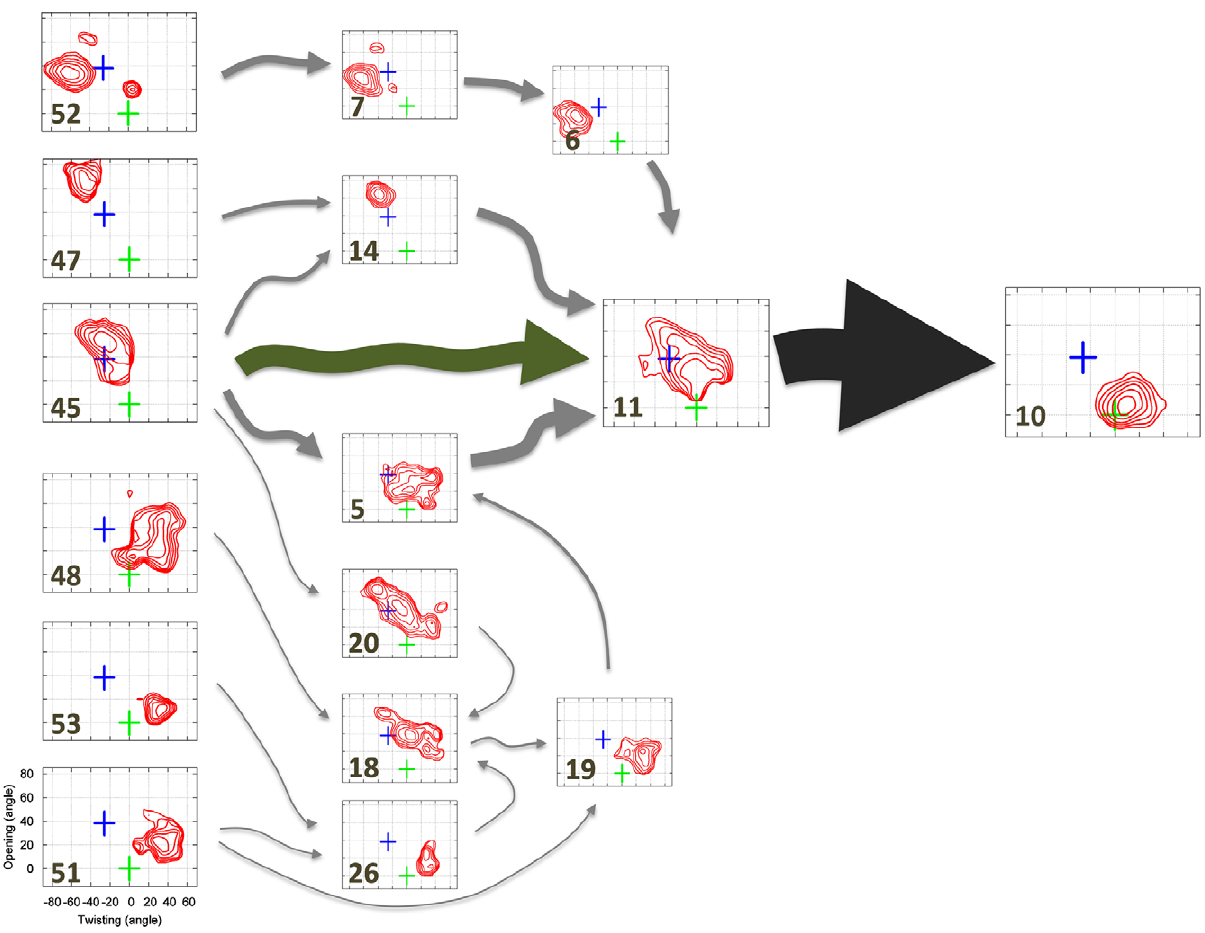
Figure 4. Superposition of the 10 highest flux pathways from the unbound states to the bound state as in Fig. 2 but with representative structures replaced with free energy plots of the protein opening angle versus twisting angle. The green and blue crosses correspond to X-ray structures of the bound and apo conformations respectively. The bin size is (5 u , 5 u ), and the interval between contour levels is 0.5 KT (same as Fig. 2b). The conformational selection and induced pathways from the unbound states to the encounter complex state is shown in green and grey arrows respectively.